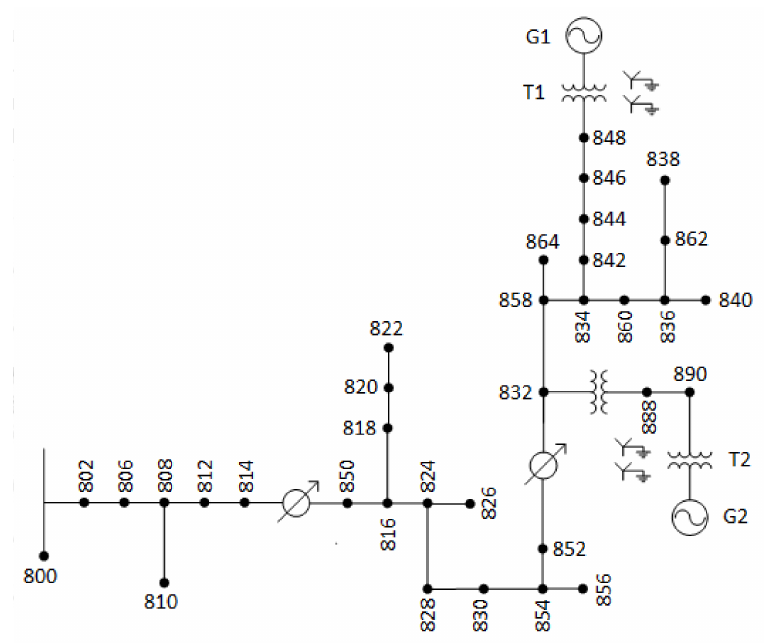
Figure 8. 34 bus radial test system with the placement of wind turbines (redrawed from